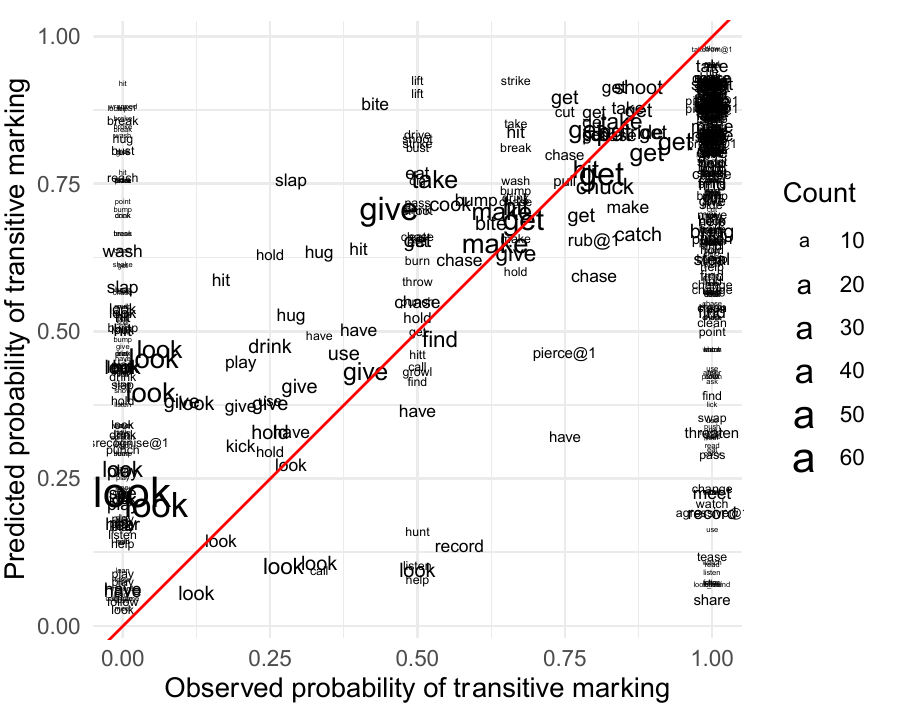
Figure 2. Predicted vs. observed probability of transitive marking, for each combination of speaker and verb.